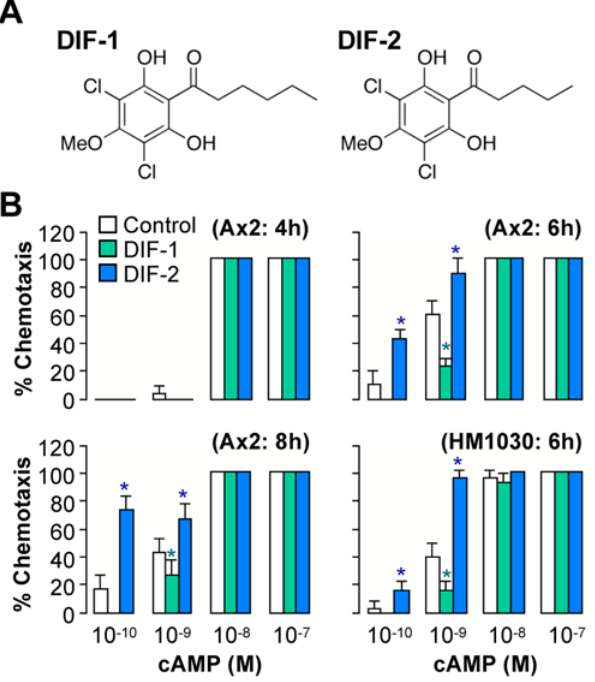
Figure 1. Effects of DIF-1 and DIF-2 on chemotaxis in Ax2 and HM1030 ( dmtA - ) cells. (A) Chemical structure of DIF-1: 1-(3,5-dichloro- 2,6-dihydroxy-4-methoxyphenyl)hexan-1-one and DIF-2: 1-(3,5-dichloro- 2,6-dihydroxy-4-methoxyphenyl)pentan-1-one. (B) Ax2 and HM1030 cells were starved for 4–8 h (as indicated in parentheses) in shake- culture, and cell droplets were spotted on PB agar containing 3 mM caffeine (Control) plus 100 nM DIF-1 or DIF-2. Cells were assayed for chemotaxis toward the indicated doses of cAMP (10 cell droplets were examined for each cAMP concentration). Data are the mean and s.d. (bars) of three independent experiments (n=3). * P , 0.05, as compared with Control.